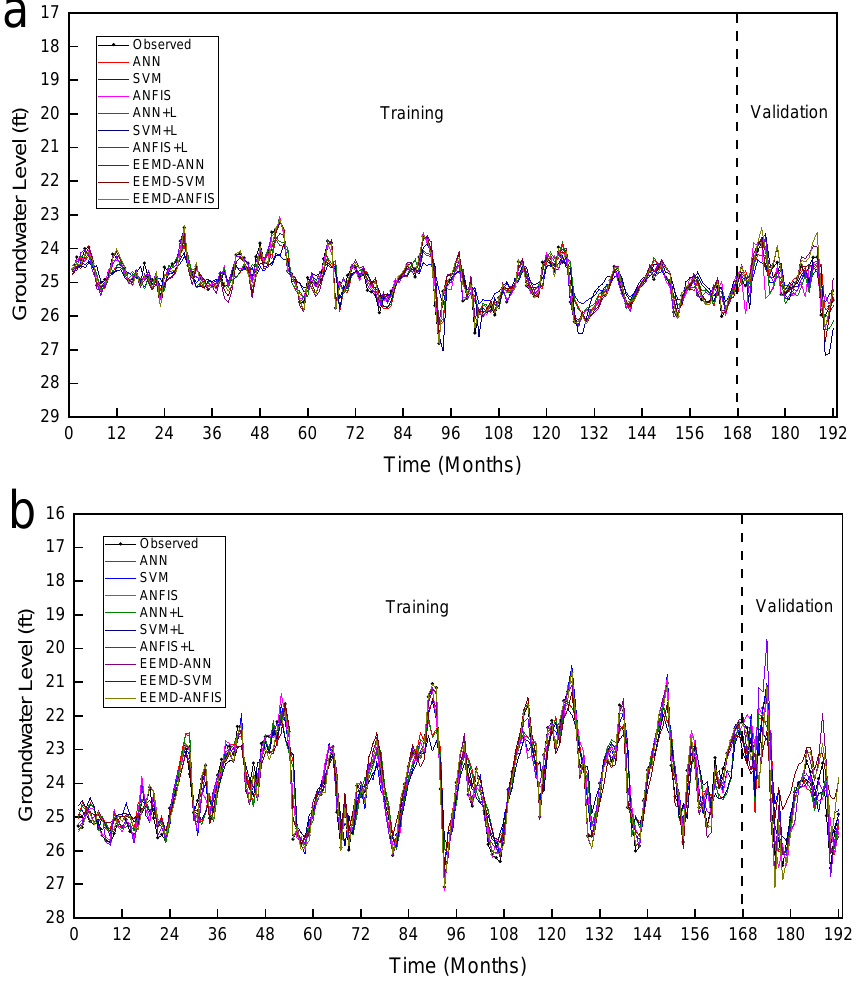
Figure 16. Model predictions versus observed data ( a ) M1255 and ( b ) STL185.